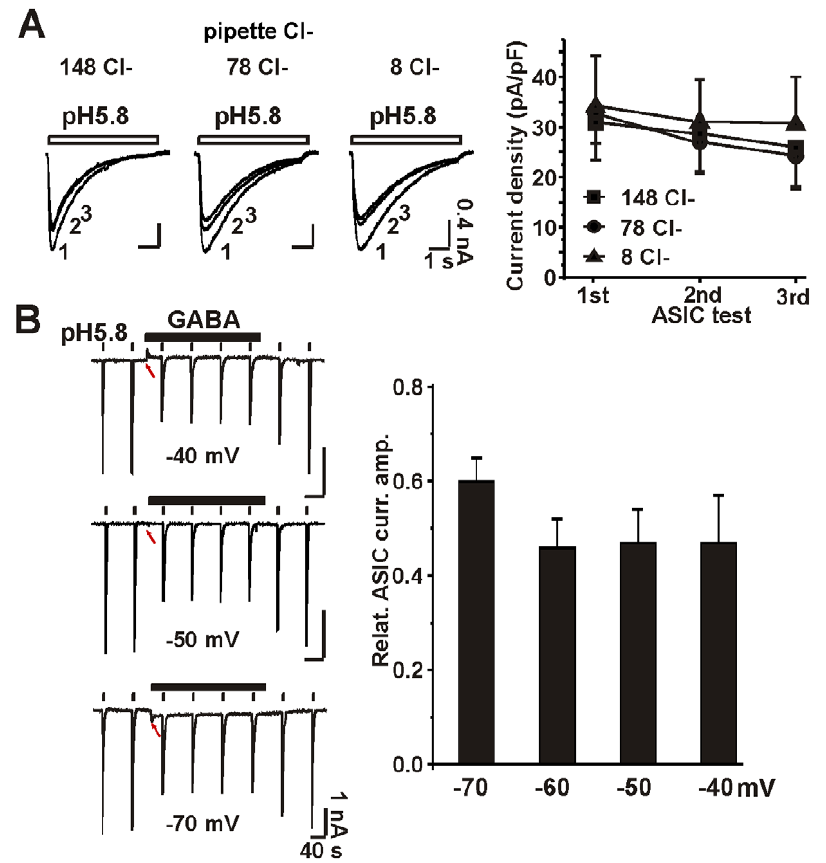
Figure 2. ASICs are not inhibited by intracellular chloride ions. A, Intracellular pipette solution containing different concentrations of chloride ions. The major salt components of the intracellular pipette solution were 140 mM KCl, 70 mM KCl/70 mM K-gluconate or 140 mM K-gluconate, resulting in chloride concentrations of 148, 78 and 8 mM, respectively (see Methods section for other ingredients). ASIC currents were tested three times (once per minute) immediately after the whole-cell recording configuration was established. The figure shows representative traces (left, super- imposed) and current density of ASICs (right) for the first three tests. There were no differences in the ASIC current density recorded using the three different intracellular pipette solutions. n=11–17. ANOVA test, p=0.95, 0.92 and 0.84 for the 1st, 2nd and 3rd, respectively. B, both direction of Cl- flux inhibit ASIC currents. Membrane potentials were clamped at 2 40 mV, 2 50 mV, 2 60 mV and 2 70 mV, respectively. The intracellular pipette solution contained 140 mM cesium gluconate (having 8 mM Cl- in recording pipettes). Left, representative traces of ASIC currents. Arrows indicate currents evoked by GABA. Note that at 2 50 mV, GABA elicited zero current (pointed by red arrows) but ASIC currents were still inhibited. Right, bar graph shows the ASIC inhibition by GABA at various clamping potentials. No significant differences (p=0.34) were detected by one–way ANOVA